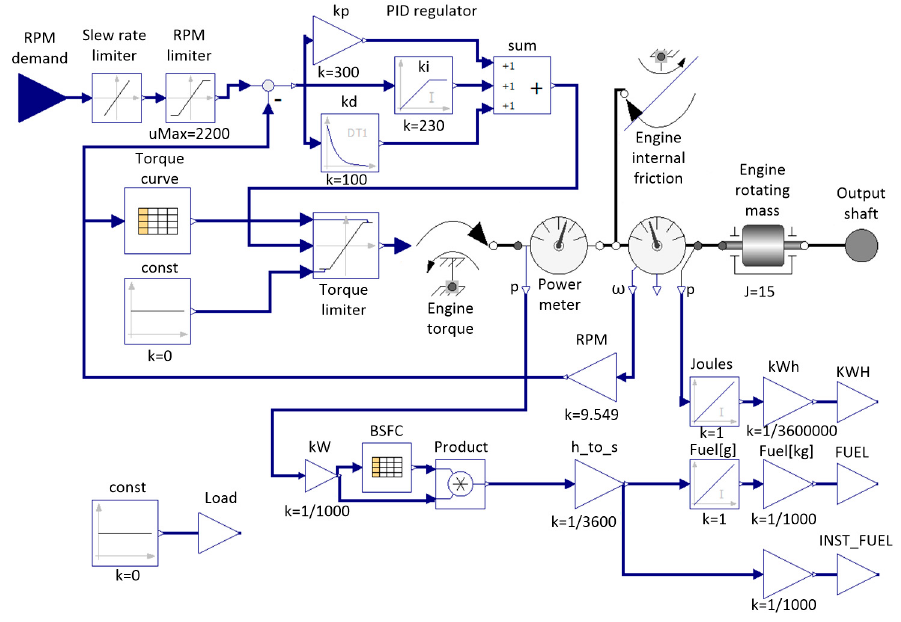
Figure 12. Model of a MAN V12-1650 diesel engine developed in Modelica.